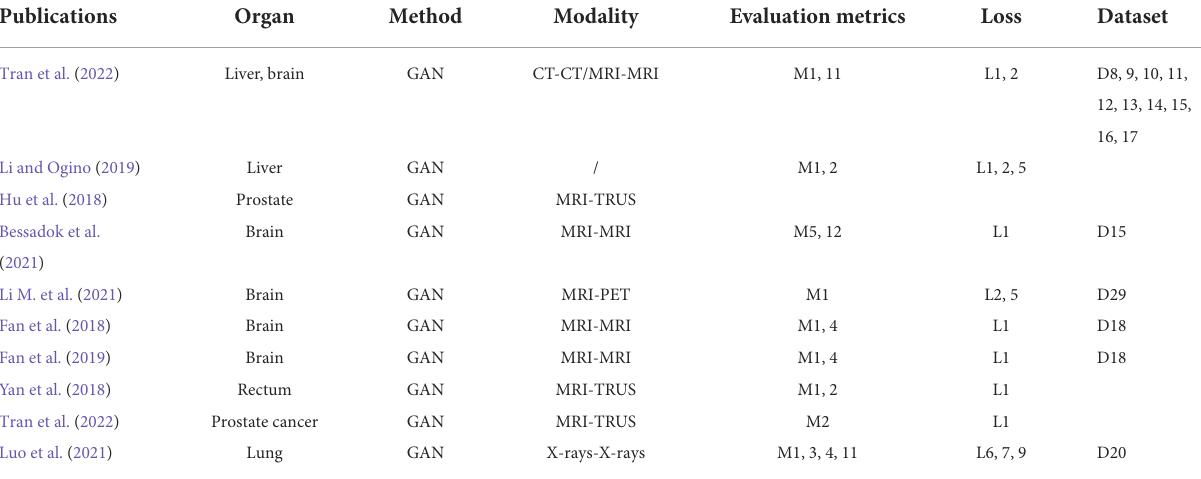
TABLE 4 Publications of adversarial strategy based.